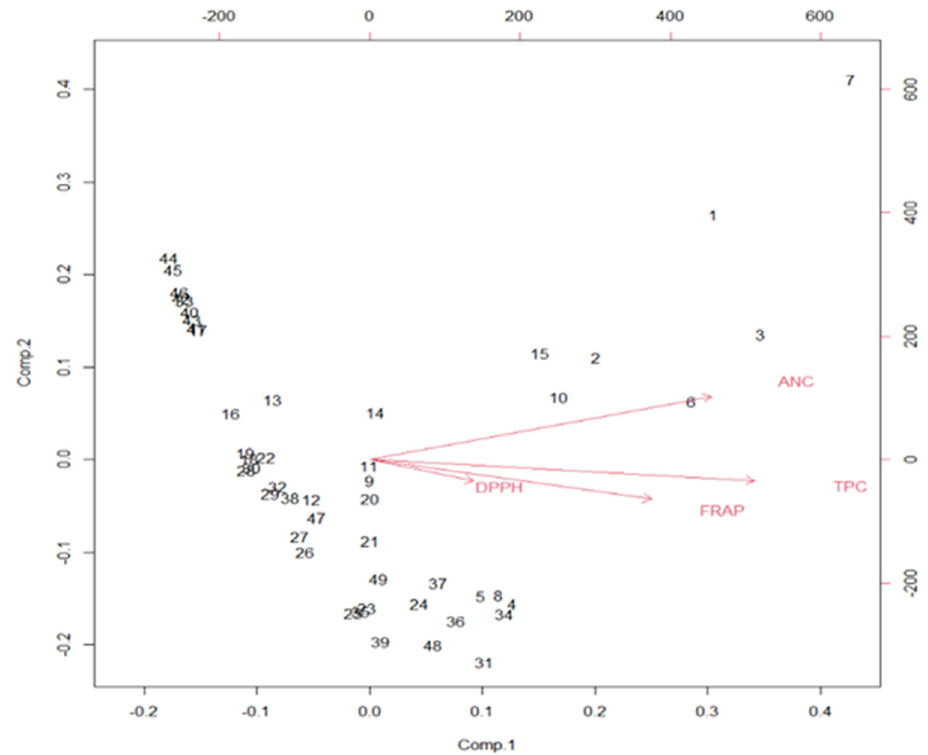
Figure 6. Principal component analysis biplot for total anthocyanin content (ANC), total phenolic content (TPC), and antioxidant activities using FRAP and DPPH methods. 1: Pusa Arun, 2: Raktima,